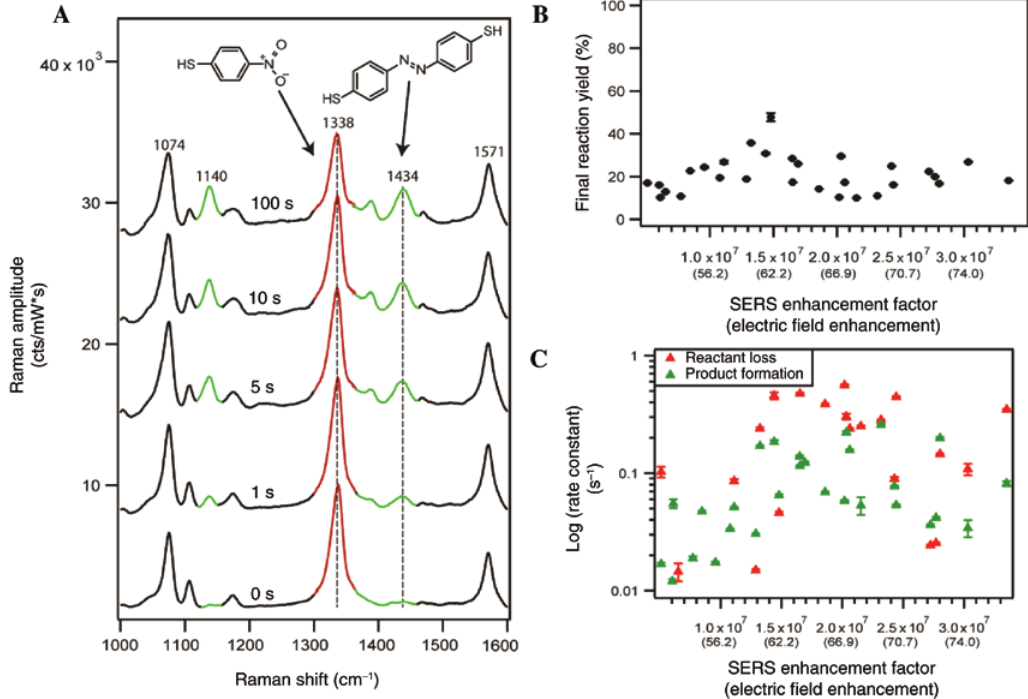
Figure 5: Field effects on plasmon-mediated dimerization of 4-NBT to DMAB tracked with SERS. (A) Time-dependent SERS spectra of the dimerization process monitored in real-time. (B) Plot of the final reaction yield’s dependence on the ensemble SERS field enhancement. The final reaction yield is a ratio of the final amplitudes of the product and reactant peaks. (C) Comparison of the rate constants for the reactant loss (red) and product formation (green) against the ensemble SERS field enhancement. Reprinted with permission from Ref. [83]. Copyright 2016 American Chemical